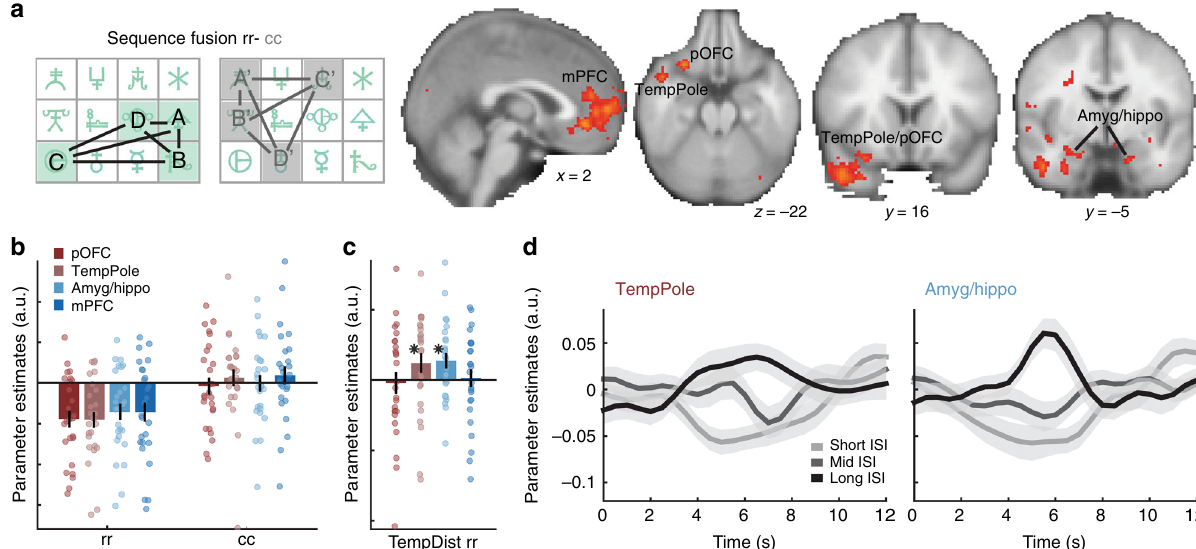
Fig. 2 Reinforced sequence knowledge in pOFC, temporal pole, amyg/hippo and mPFC. a Regions where elements of the rewarded sequence have grown together more in their neural representation than elements of the unrewarded but equally frequent control sequence. Repetition suppression predicts less activation for a RewSeq element that follows another element of RewSeq (i.e., after a pair including two elements of A, B, C, or D: rr), compared to a ConSeq element that follows another element of ConSeq (pairs made up of A ′ , B ′ , C ′ , or D ′ : cc), if their representations overlap more strongly (i.e., recruit the same neural populations). In this contrast, we identi fi ed medial prefrontal cortex (mPFC), temporal pole (tempPole) and (within the same cluster) posterior orbitofrontal cortex (pOFC; all cluster-corrected), and a region at the border of amygdala and hippocampus (amyg/hippo; TFCE-corrected within bilateral amygdala mask; shown at z > 2.3 uncorrected). b For illustration, parameter estimates are shown in spheres centered on the peak activation in these four regions. c Repetition suppression effects in temporal pole and amyg/hippo were modulated by the temporal distance between successive RewSeq elements, with stronger suppression for shorter inter-stimulus intervals (ISI) as predicted (short < 2 s, mid = [2,3.5] s, long > 3.5 s; * p < 0.05 in one-sample t -test). d The raw BOLD time-series in temporal pole (left) and amyg/hippo (right) in response to the second of two successive RewSeq elements after a short, mid or long ISI illustrate the BOLD modulation shown in panel c . Error bars denote SE; see also Supplementary Fig.